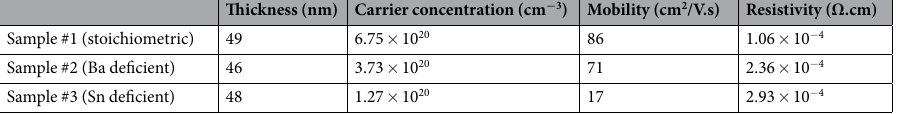
Table 1. DC extracted parameters for the analyzed BSO